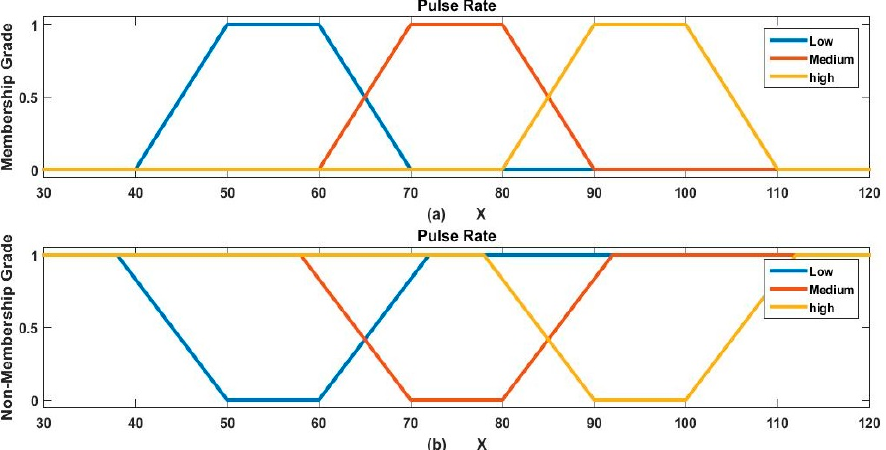
Figure 3. Three linguistic categories of sugar with their trapezoidal membership ( a ) and non-membership grades ( b ).